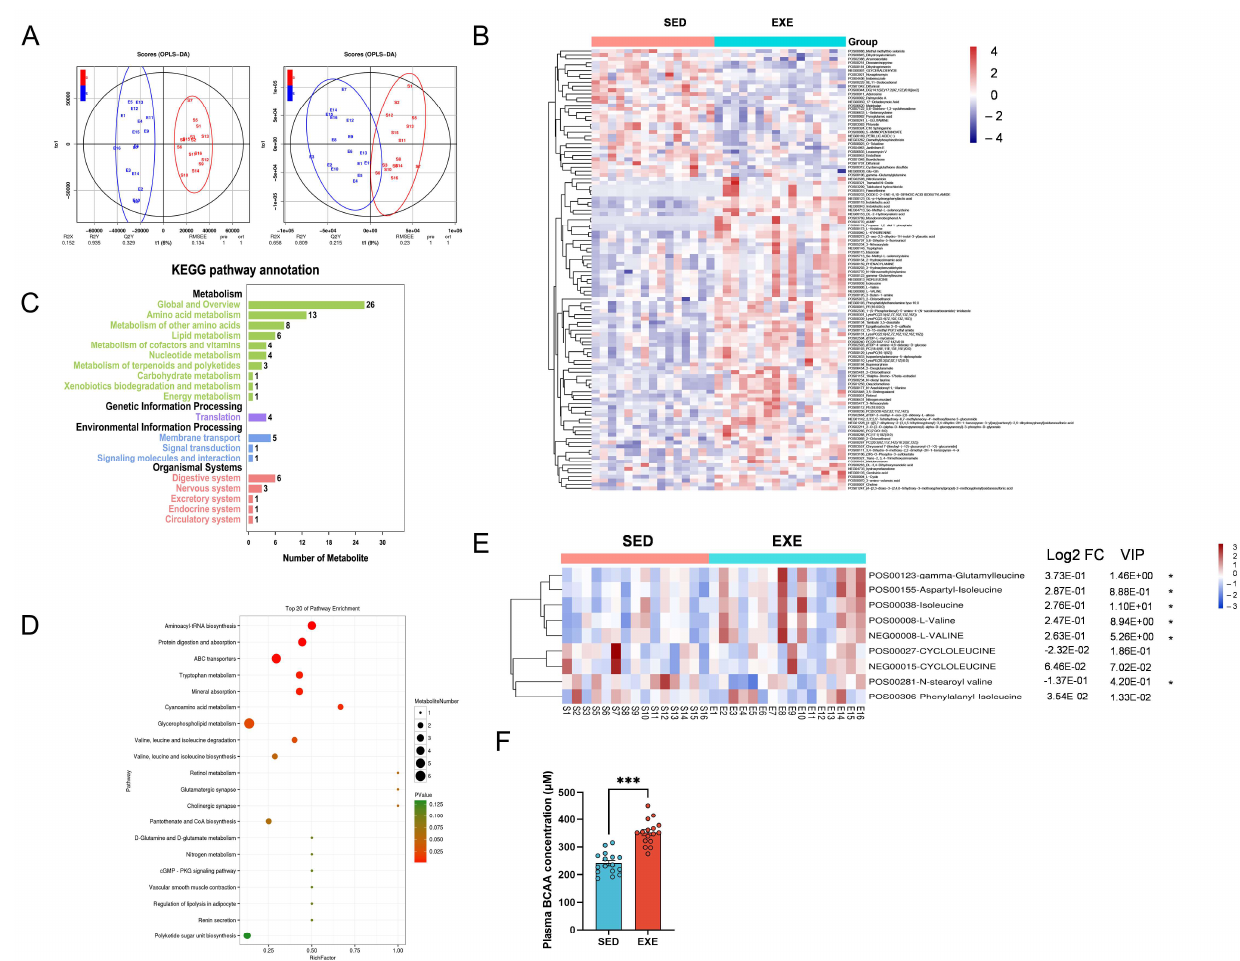
Figure 1. Exercise upregulated circulating BCAA levels in humans. ( A ). The clustering of orthog- onal projection to latent structures-discriminant analysis (OPLS-DA) in positive (left panel) and negative (right panel) ion mode. ( B ). Heat map of the differentially concentrated metabolites in plasma from trained and untrained subjects. ( C ). The KEGG pathways involved in the differentially concentrated metabolites. ( D ). Pathway enrichment analysis indicated that both BCAA degradation and biosynthesis were changed obviously. ( E ). Heat map of all detected BCAAs. ( F ). Circulating BCAA concentrations in trained and untrained subjects. Values are presented as mean ± SEM. n = 16 subjects for each group. * p < 0.05; *** p <